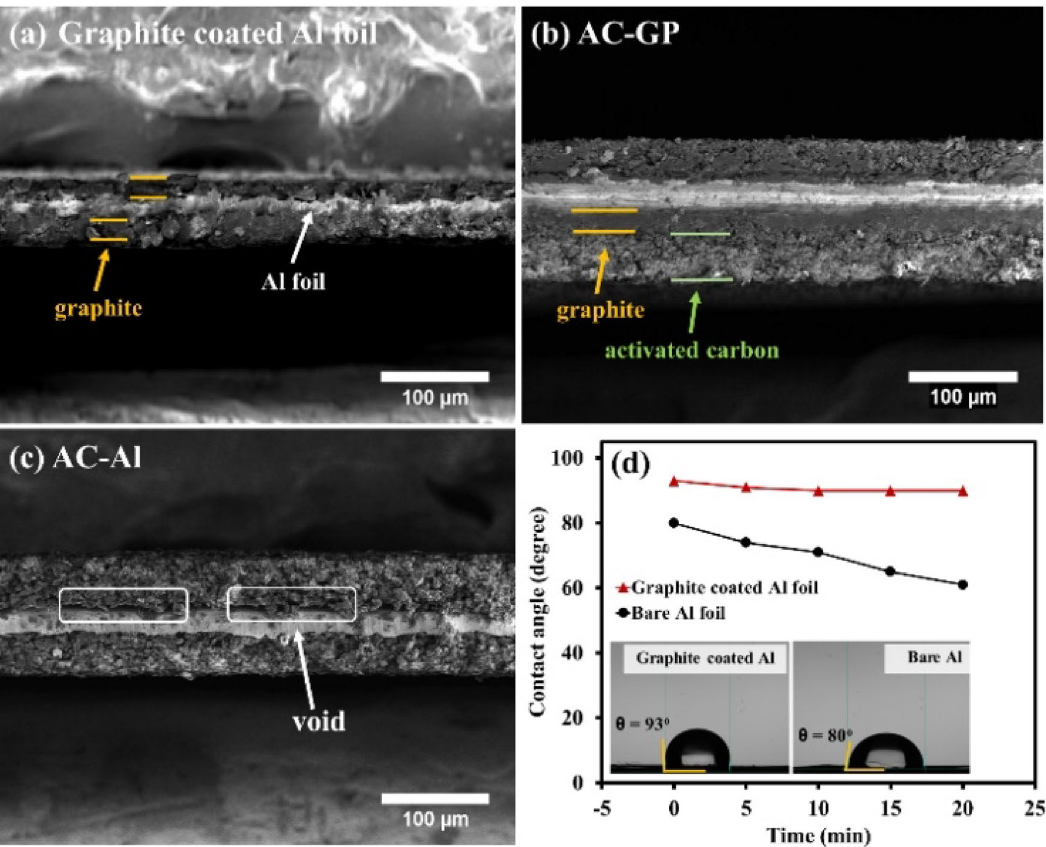
Figure 1. FESEM images of ( a ) graphite-coated Al foil, ( b ) AC-GP, and ( c ) AC-Al; ( d ) contact angle vs. immersion time (inset: the drops of 1 M Na 2 SO 4 at t = 0